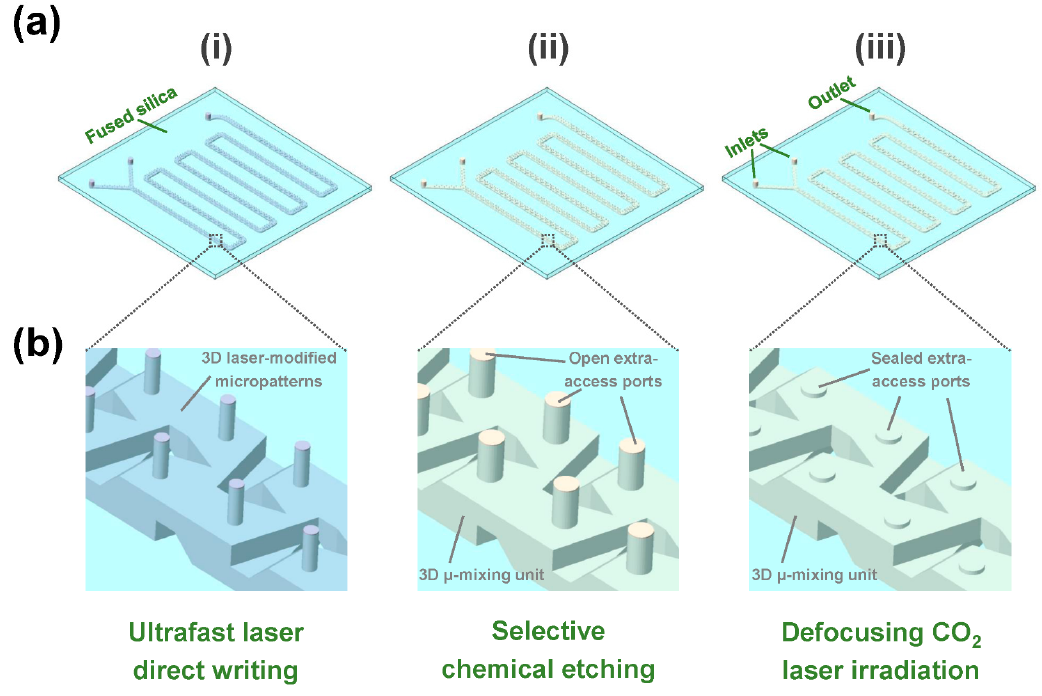
Figure 1. Schematic of the fabrication procedure for a 3D large-scale microchannel chip with two inlets and one outlet in fused silica. It consists of three main steps: ( i ) ultrafast laser direct writing of 3D modified micropatterns in glass; ( ii ) selective chemical etching of hollow glass microstructures including 3D microchannels, micromixing units, and open extra-access ports; and ( iii ) defocusing CO 2 laser irradiation for sealing the extra-access ports. ( b ) Close-up view of a 3D micromixing unit with several extra-access ports indicated by a dashed rectangle at each step in ( a